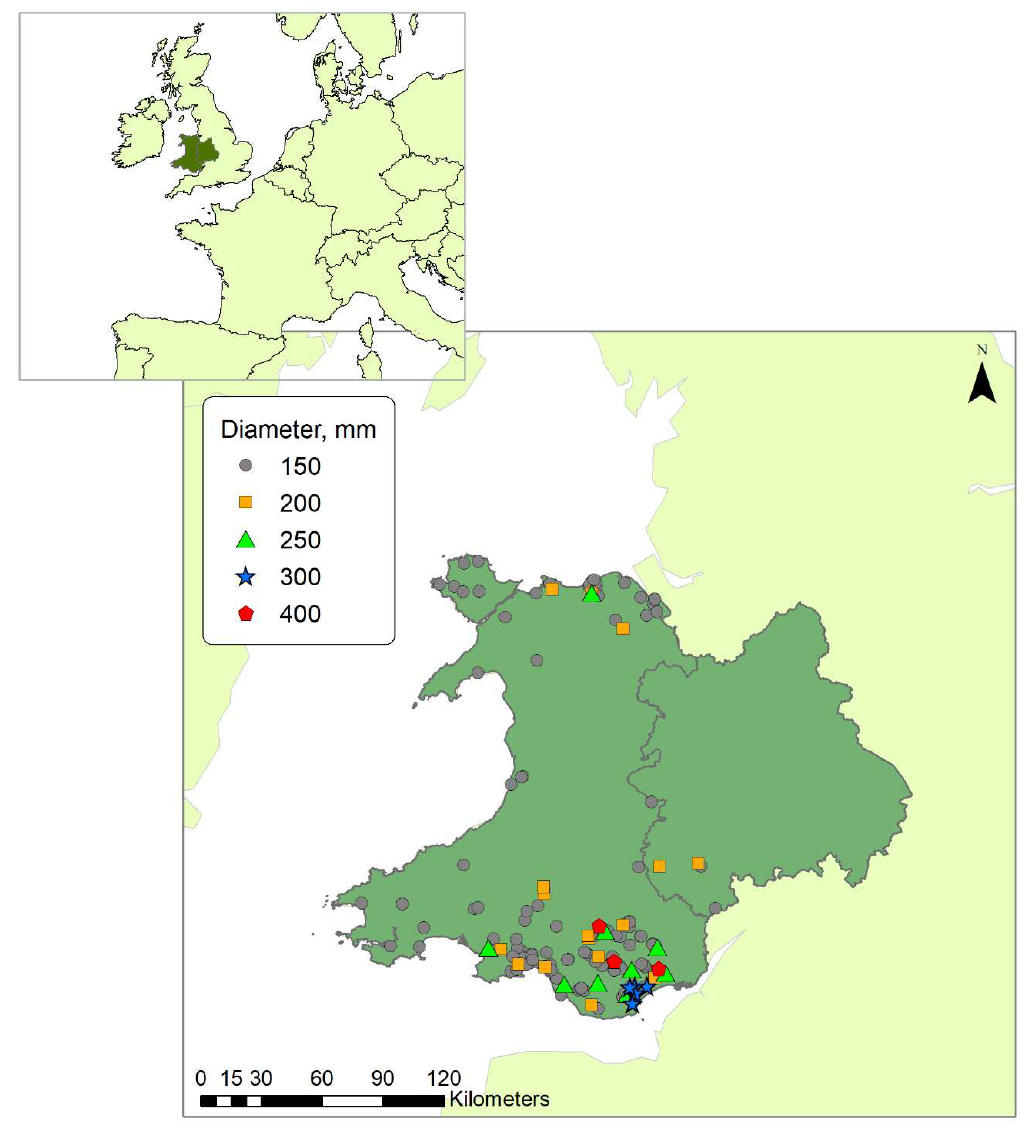
Figure 4. Location of the selected PRV sites.